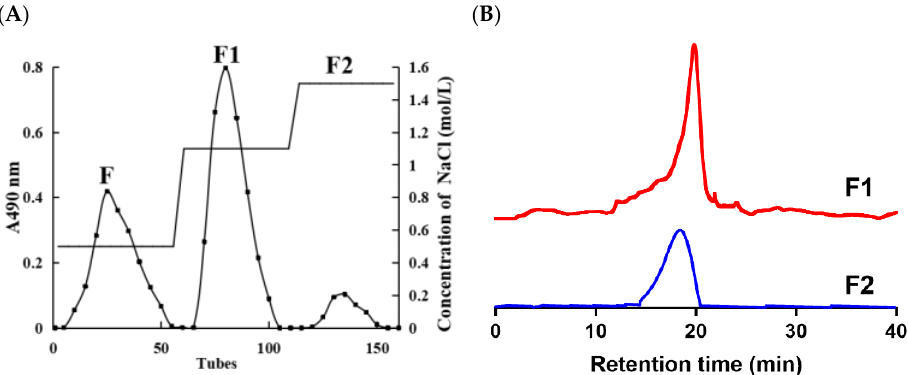
Figure 1. Elution curve of heparinoid in shrimp head of FPA98 Cl column ( A ), HPGPC chromatogra- phy of F1 and F2 ( B ).